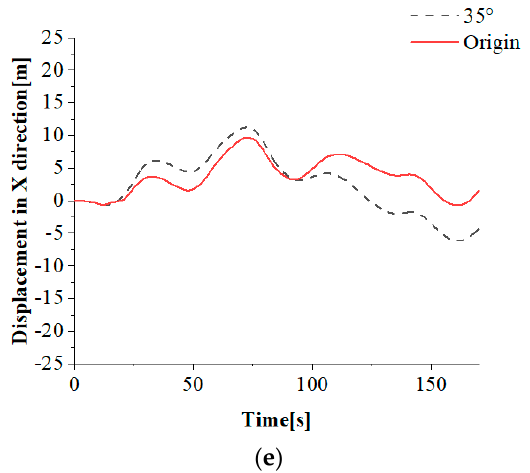
Figure 30. X direction displacement of the pedestal under different wave heights. ( a ) H = 9 m; ( b ) H = 7.2 m; ( c ) H = 5.4 m; ( d ) H = 3.6 m; ( e ) H = 1.8 m.